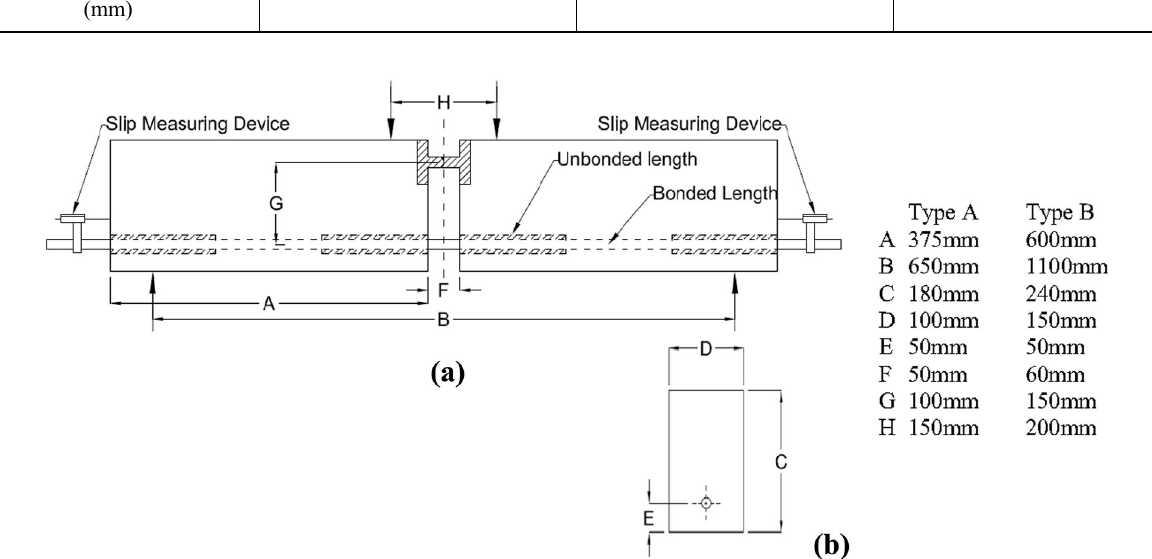
Fig. 1 RILEM beam geometry: a elevation view; b cross-sectional